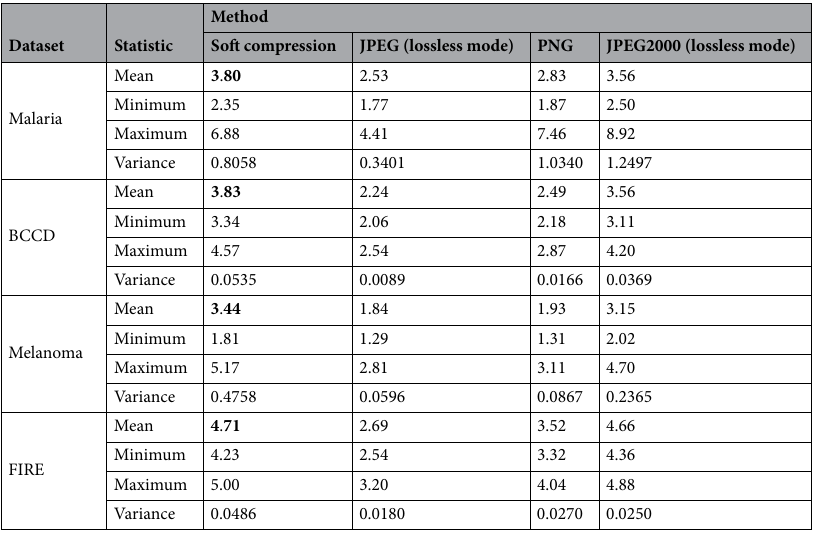
Table 2. Some statistics about compression ratio of Malaria, BCCD, Melanoma and FIRE datasets by using different compression methods (JPEG and JPEG2000 are in lossless mode).